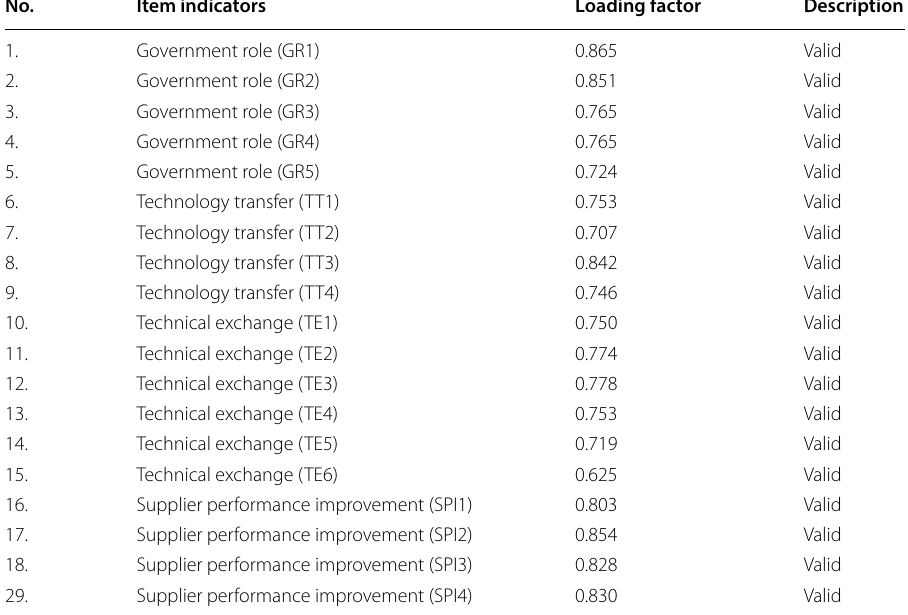
Table 4 Validity test. Source : Author Data, Smart PLS 3.2.7